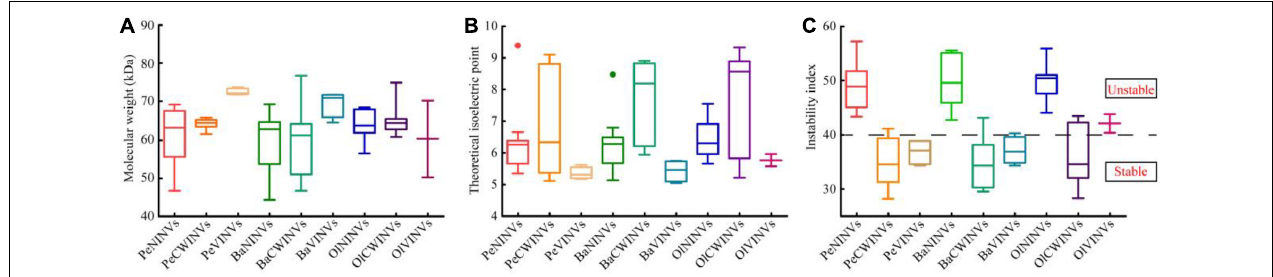
FIGURE 1 | Amino acid characteristics of INVs in three bamboo species (Pe, Ba, and Ol indicate Phyllostachys edulis , Bonia amplexicaulis , and Olyra latifolia , respectively). (A) Molecular weight of proteins. (B) Theoretical isoelectric point (pI) of proteins. (C) Instability index of